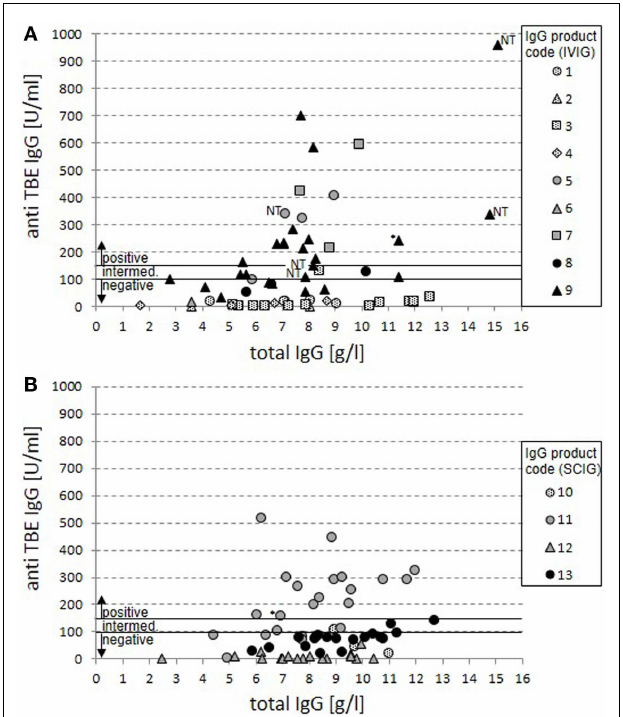
FIGURE 1 |Anti-TBE IgG vs. total IgG serum levels in patients under IgG replacement therapy . Anti-TBE IgG titers measured by standard ELISA are shown in relation to total IgG serum levels for 60 cases from patients treated with IVIG (A) and 62 cases from patients treated with SCIG products (B) . Each case of patient-product combination is presented by a single value. Product codes are assigned to symbols with dotted filling representing North-American origin of plasma, gray filling mixed origin, and black filling European origin.The anti-TBE antibody titers for positive ( > 150U/ml), intermediate (100–150U/ml), and negative ( < 100U/ml) serum titers are marked. In four cases on IVIG replacement with positive anti-TBE titers, only non-trough levels were available (NT). Positive values are also marked in two cases where a sustained active anti-TBE antibody response cannot be excluded because of normal switched memory B cells and vaccination (*).